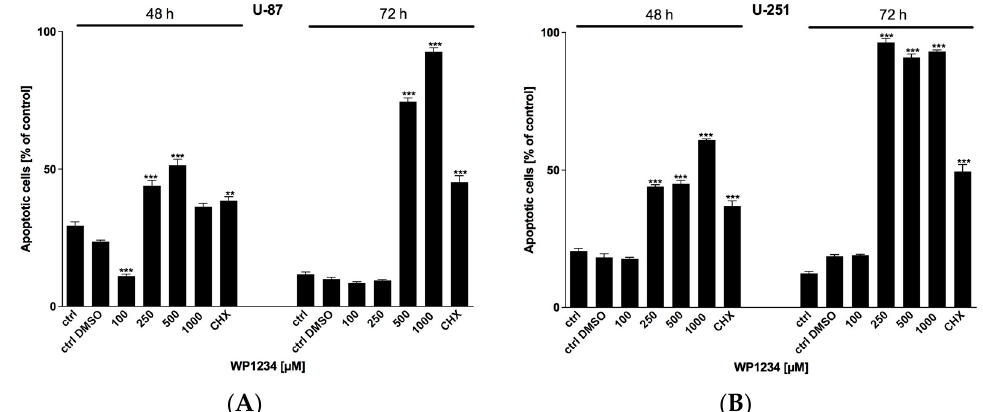
Figure 8. Annexin V-positive ( A ) U-87 and ( B ) U-251 cells after 48 and 72 h treatment with various concentrations of WP1234 (100–1000 μ M). As a reference cytotoxic agent, CHX (20 μ M) was used. Significant differences between the treatment and control (untreated cells) means are indicated by * p < 0.05, ** p < 0.01, *** p < 0.001.